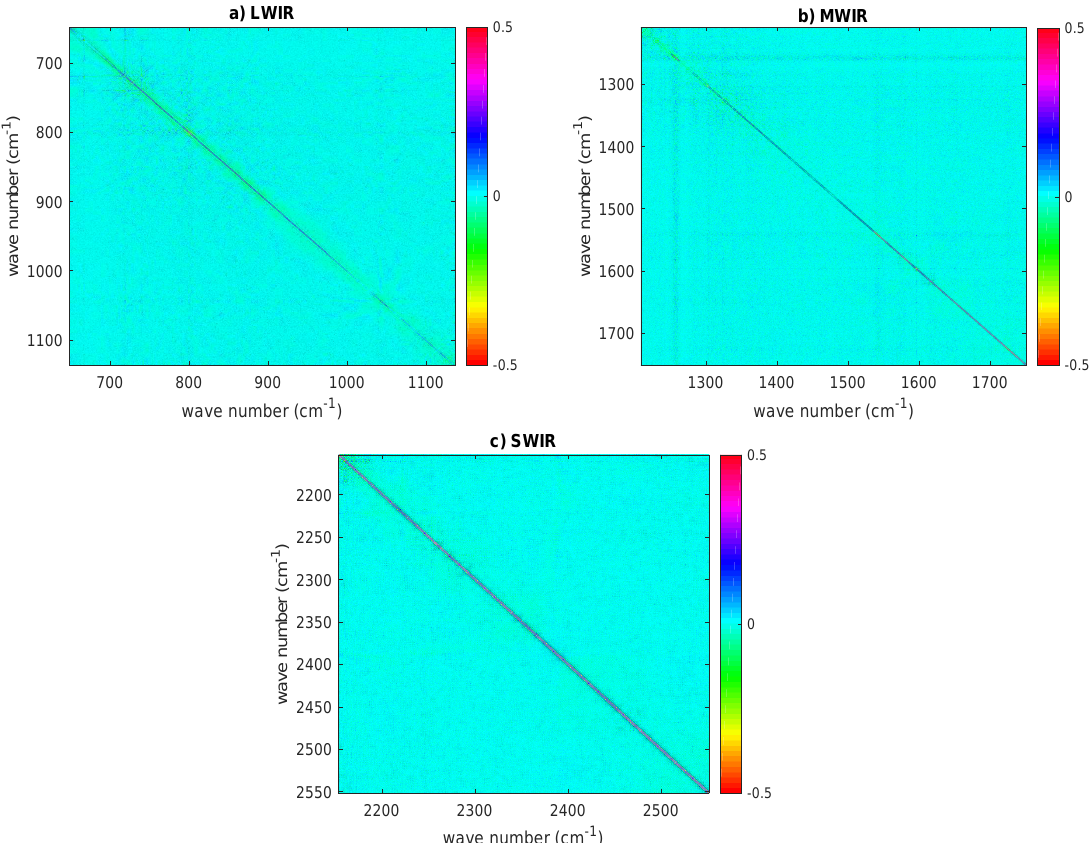
Figure 13. HIRAS estimated correlation matrix (dataset corresponding to the tropical belt and recorded on 8–9 June 2018) for: ( a ) LWIR; ( b ) MWIR; and ( c ) SWIR. The sampling is 0.625 cm − 1 in each band. In all correlation matrices, the diagonal has been subtracted to allow for a better visual inspection for possible correlation patterns. Results have been averaged over the four HIRAS